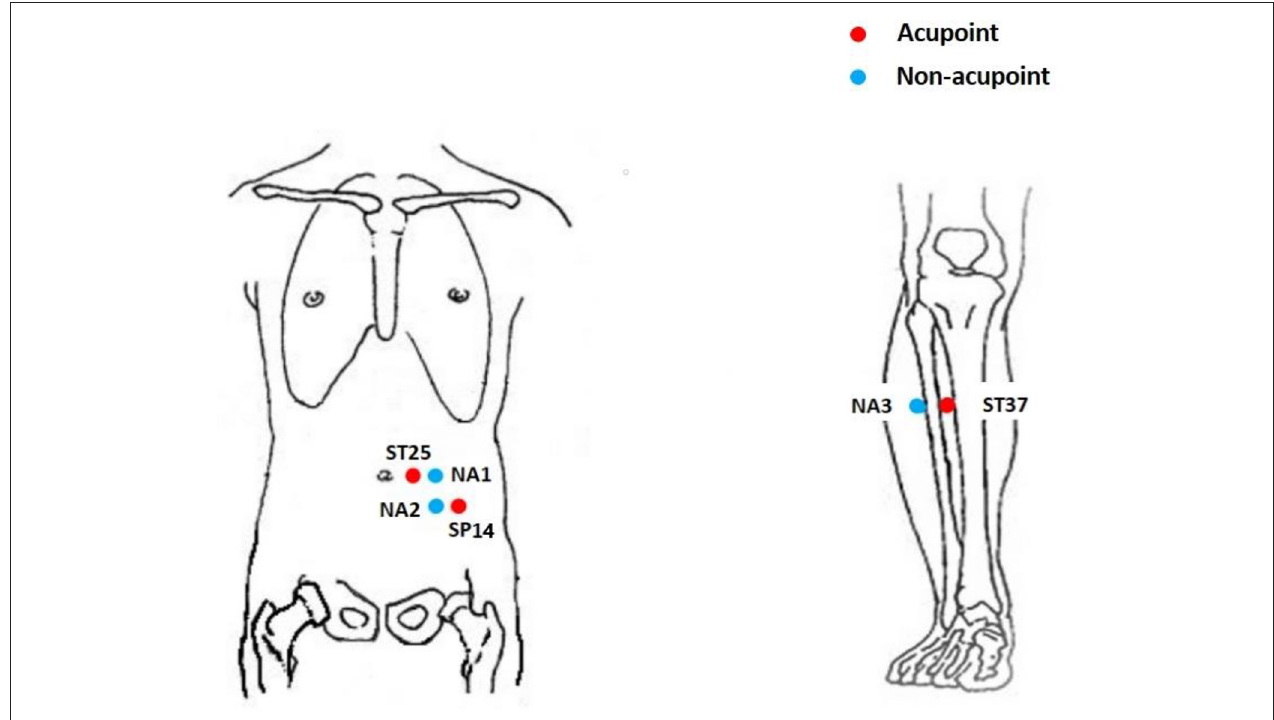
FIGURE 2 | Location of acupoints and